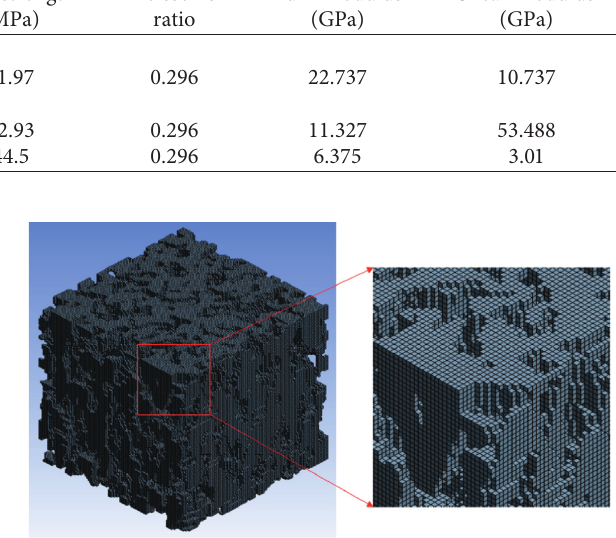
Figure 2: Rock skeleton finite element mesh